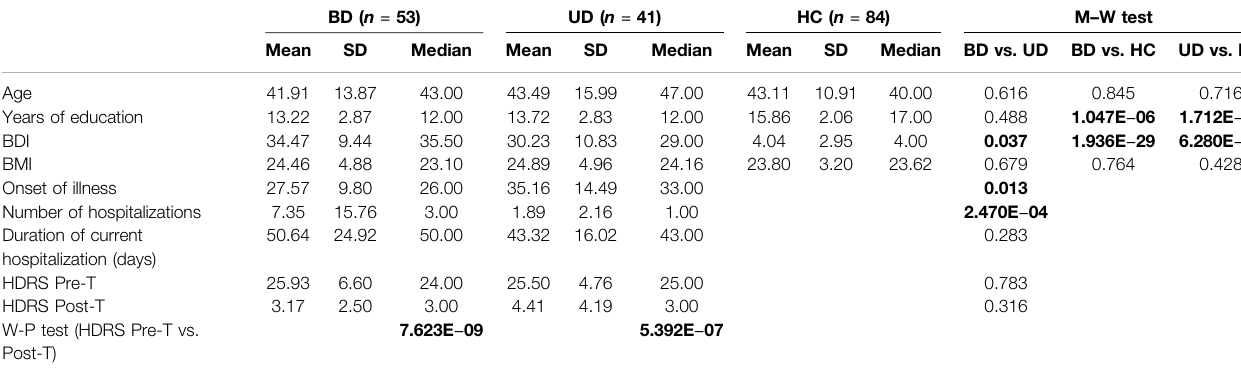
TABLE 2 | Clinical description of the study population.